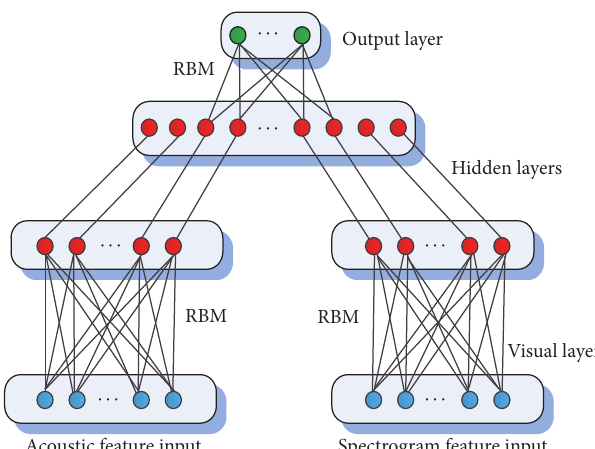
Figure 5: DBN21 model.